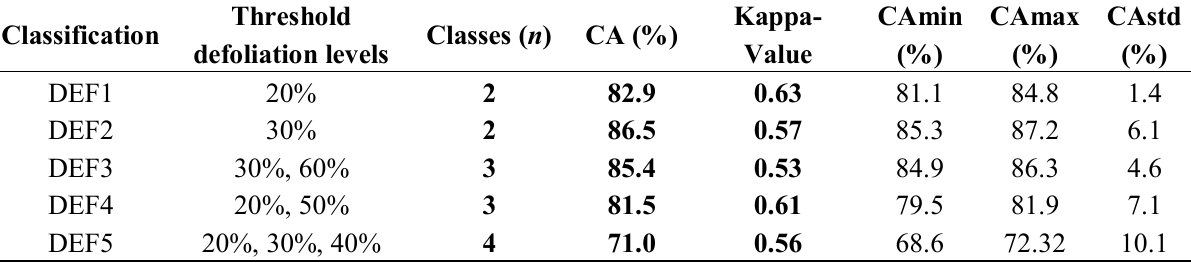
Table 5. The overall classification accuracy (CA), minimum and maximum accuracies and kappa values for different needle loss category classification schemes (Derived from full point density). The trees having defoliation level less than threshold value were assigned to a class of lower defoliation level.